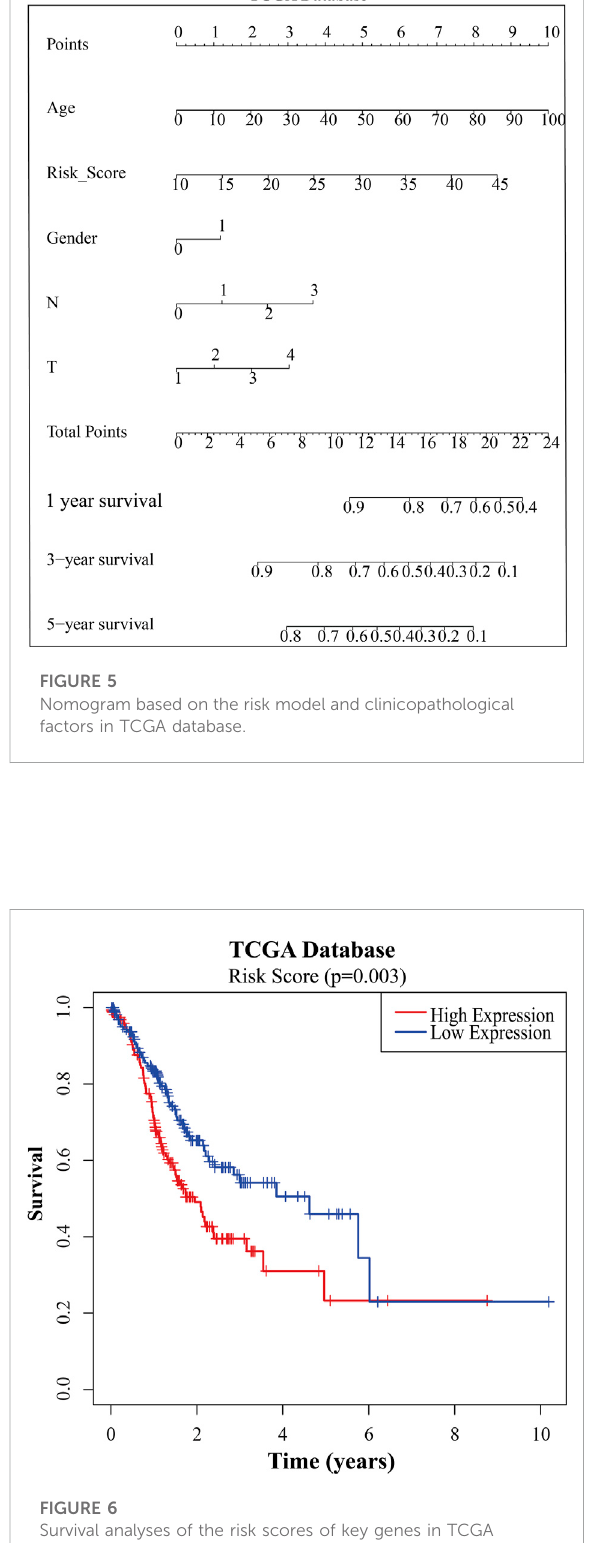
TABLE1 Univariate and multivariate analyses of the prognostic risk model in TCGA